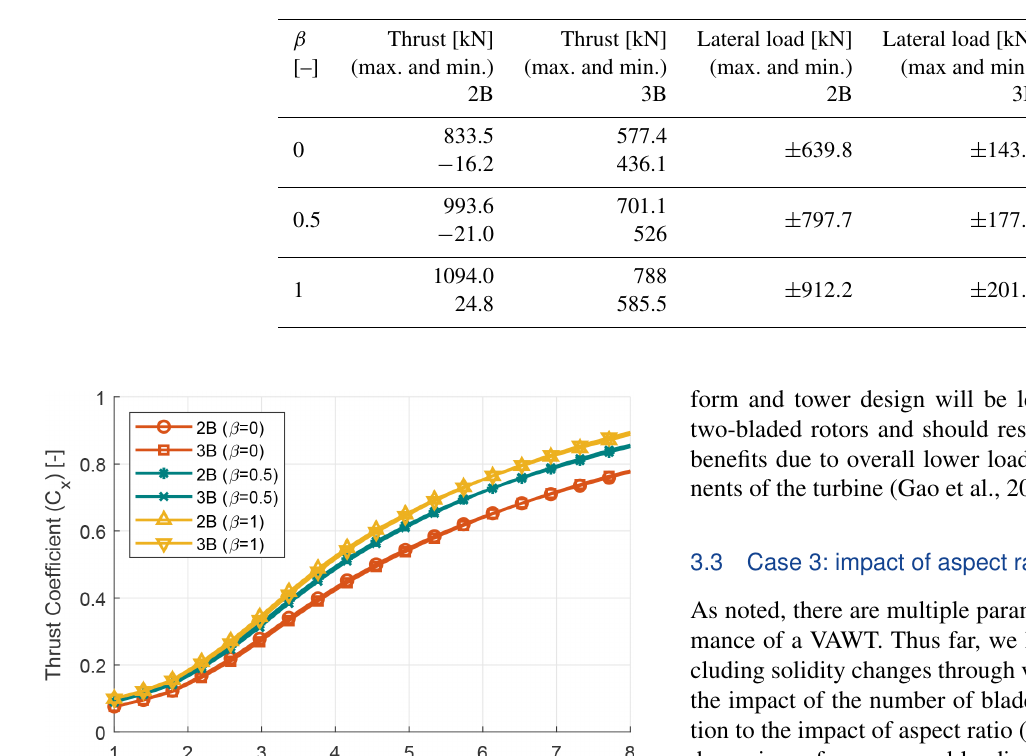
Figure 14. Power coefficients ( C P ) versus TSR for two-bladed (2B) and three-bladed (3B) rotor at low wind speed (5ms − 1 ). Table 3. Maximum and minimum of parked thrust ( F X ) and lateral ( F Z ) loads.